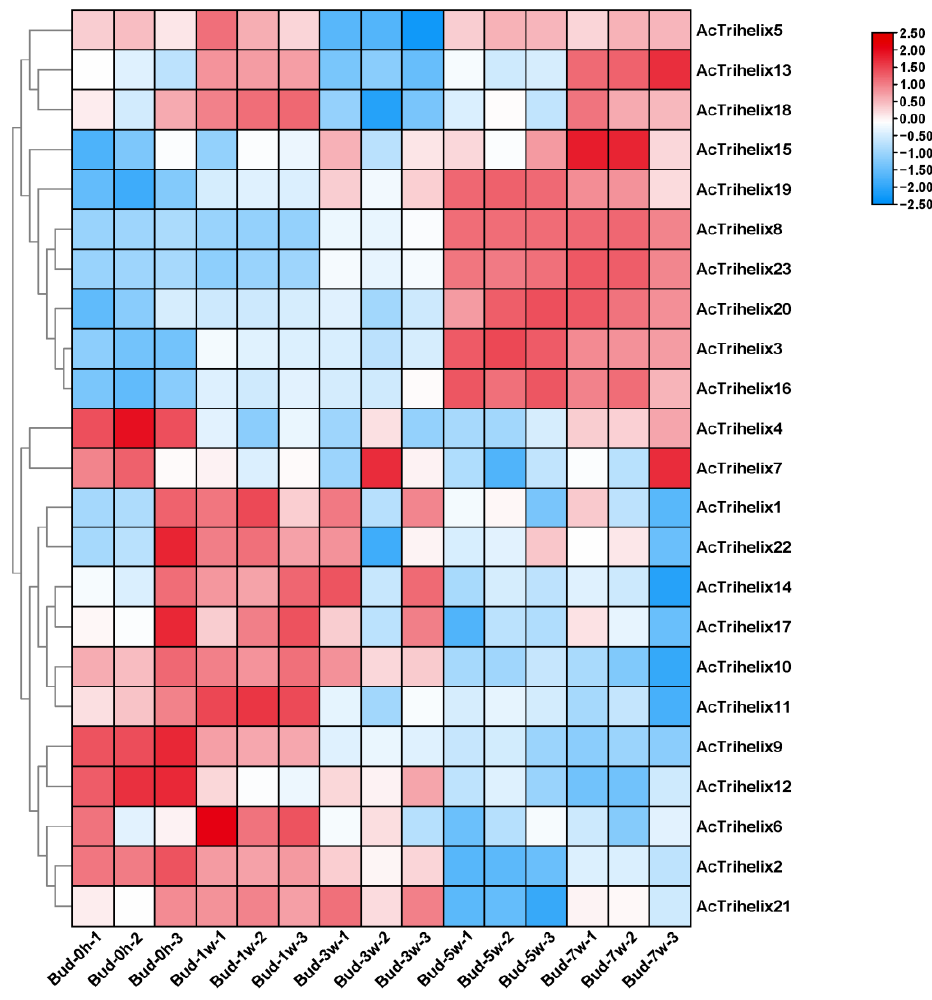
Figure 7. Expression profile of AcTrihelix genes in flower induction and flowering process. The labels Bud ‐ 0h, Bud ‐ 1w, Bud ‐ 5w, and Bud ‐ 7w on the X ‐ axis represent the time (0 h, 1 week, 3 weeks, 5 weeks, and 7 weeks) after ethephon treatment. The number represents the three biological replicates of each sample. The Y ‐ axis refers to the deduced FPKM value normalized with Log2.